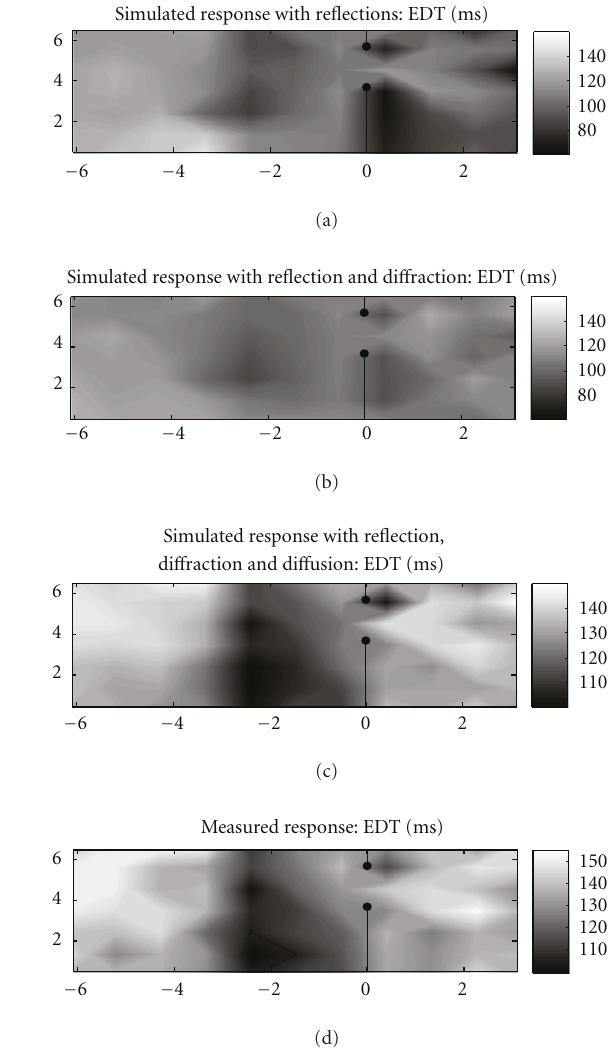
Figure 18: Floor-map of the validation environment: the grid represents the 77 acquisition points and the loudspeaker location is marked with a dot.